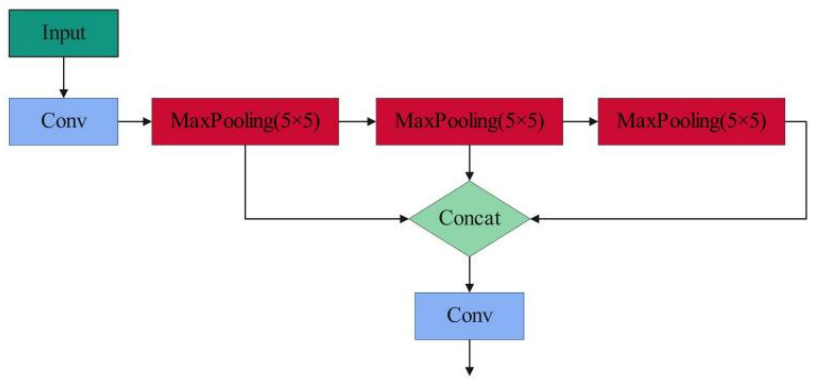
Figure 5. Structure diagram of SPPF (The arrows indicate the direction of forward propagation).